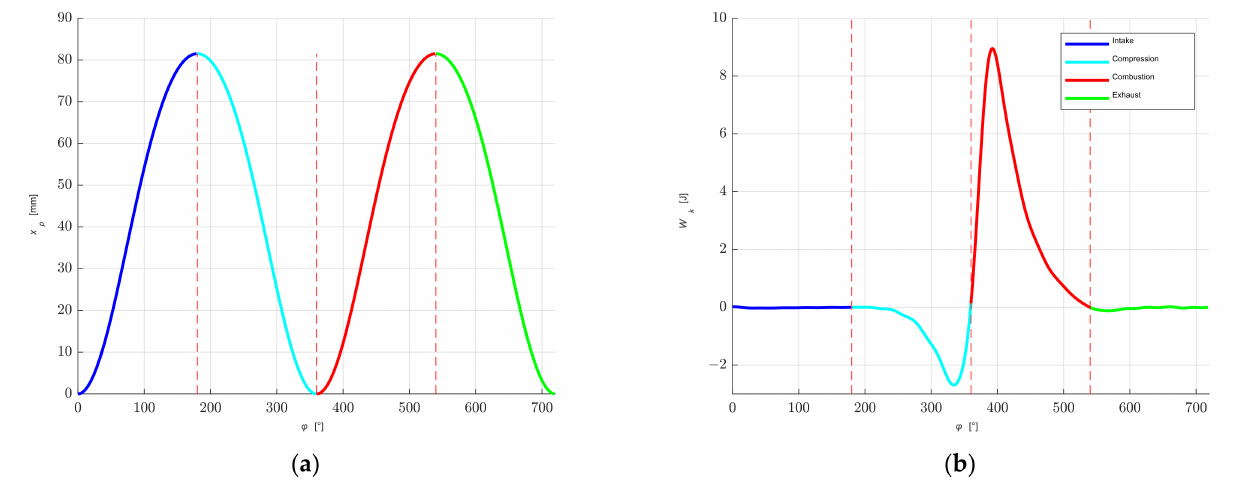
Figure 12. The displacement of the piston x p depending on the angle of rotation for the engine under test ( a ) and the W i_k values for subsequent angles of rotation of the shaft ( b ).